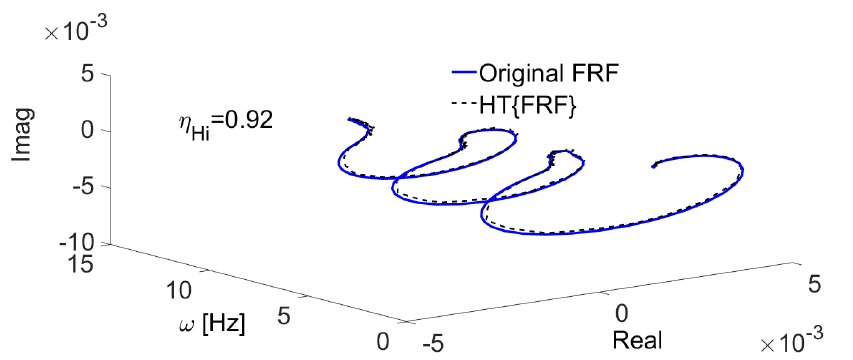
Figure 12. Experimental FRF of the three-story building-like structure with autoparametric absorber in blue line and its corresponding Hilbert transformation in dotted black